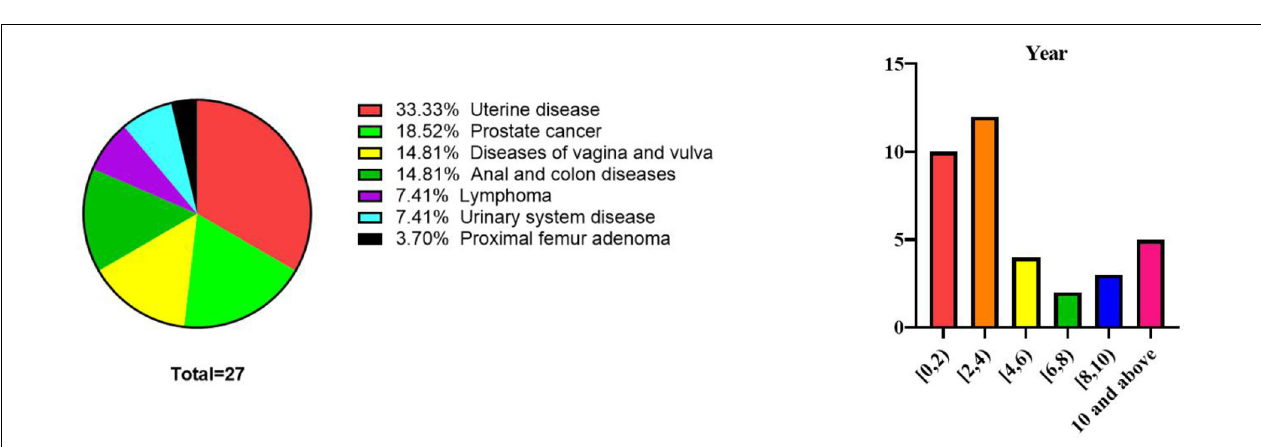
FIGURE 3 | Flow chart depicting the systematic review process used in this study.